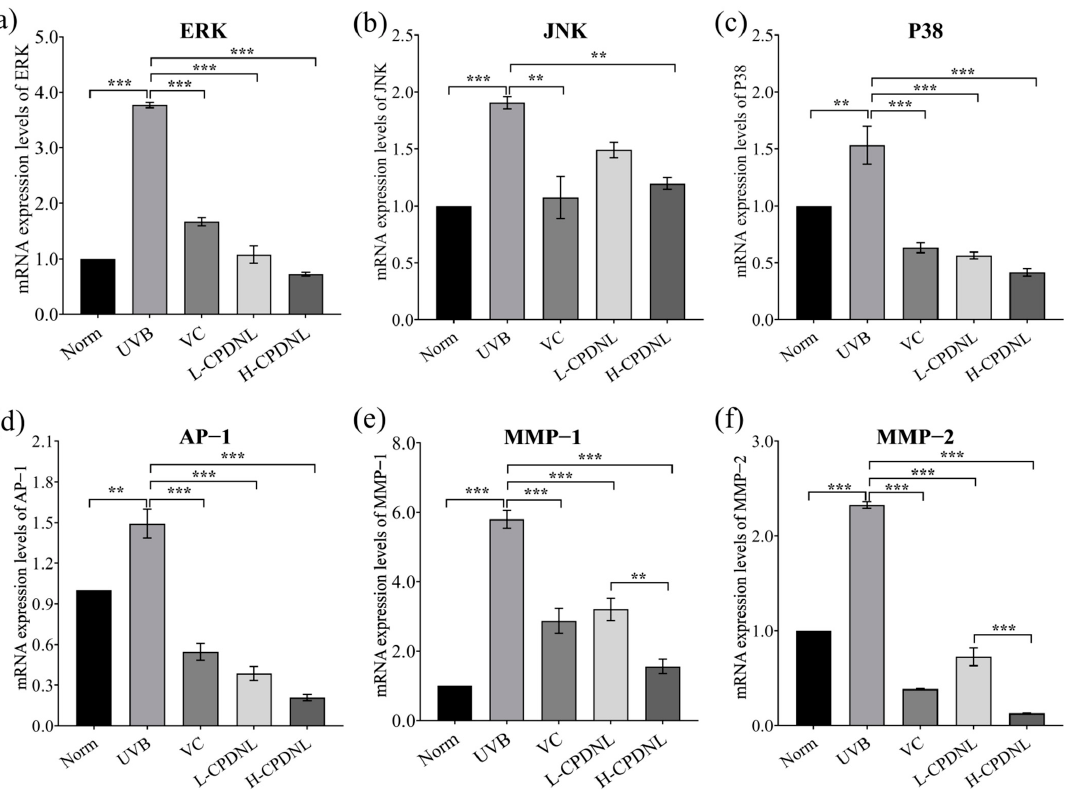
Figure 9. The effect of CPDNL on mRNA expression of MAPK/AP-1/MMP signaling pathways in UVB-induced skin. ( a–c ) The mRNA expression of ERK, JNK, and P38; ( d ) the mRNA expression of AP-1; ( e , f ) the mRNA expression of MMP-1 and MMP-2. Data are presented as mean ± SEM. ** p < 0.01 and *** p < 0.001.